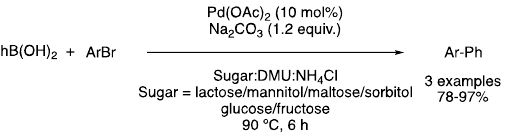
Figure 17. First Suzuki reaction in DESs.